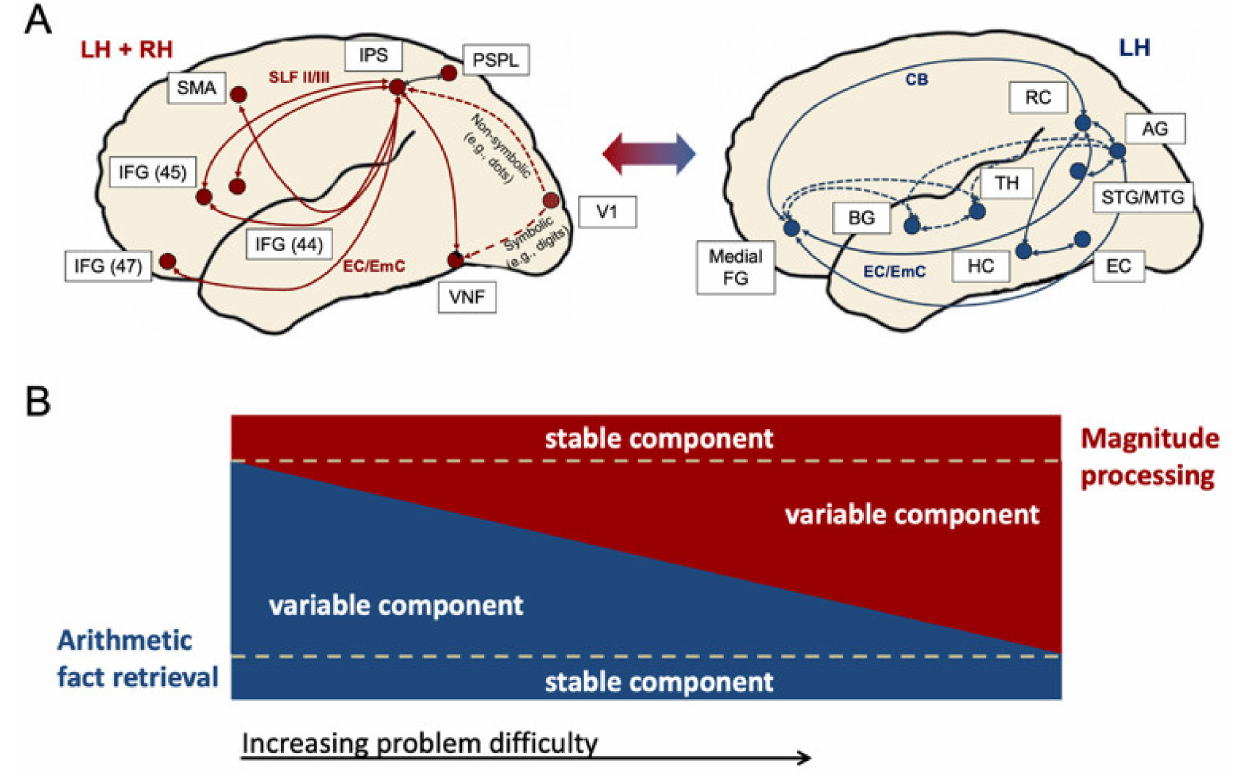
Figure 5. ( A ) Cortical networks and processing pathways for magnitude processing (left panel, red) and arithmetic fact retrieval (right panel, dark blue) in adults with and without DD (devel- oped based on [6,49]). The color-changing arrow between the two panels reflects that these two anatomically separate networks operate together as functionally integrated circuits in numerical cognition. ( B ) Interplay between magnitude processing and arithmetic fact retrieval. A certain amount of fact retrieval is assumed to be involved in arithmetic independent of the difficulty of the task, depicted as the blue rectangle at the bottom. However, the harder a task becomes, the less fact retrieval (blue triangle, variable fact retrieval component) and the more magnitude pro- cessing has been assumed (red triangle, variable magnitude processing component). On the other side, an invariant component of mandatorily involved magnitude processing is assumed as well, depicted as the red rectangle at the top of the figure. Abbreviations: AG—angular gyrus; BG—basal ganglia; EC—entorhinal cortex; EC/EmC—external/extreme capsule system; HC—hippocampus; IFG—inferior frontal gyrus; IPS—intraparietal sulcus; LH—left hemisphere; Medial FG—medial frontal gyrus; MTG—middle temporal gyrus; PSPL—posterior superior parietal lobule; SLF—superior longitudinal fascicle; SMA—supplementary motor area; RC—retrospenial cortex; RH—right hemi- sphere; TH—thalamus; V1—primary visual cortex; VNF—visual number